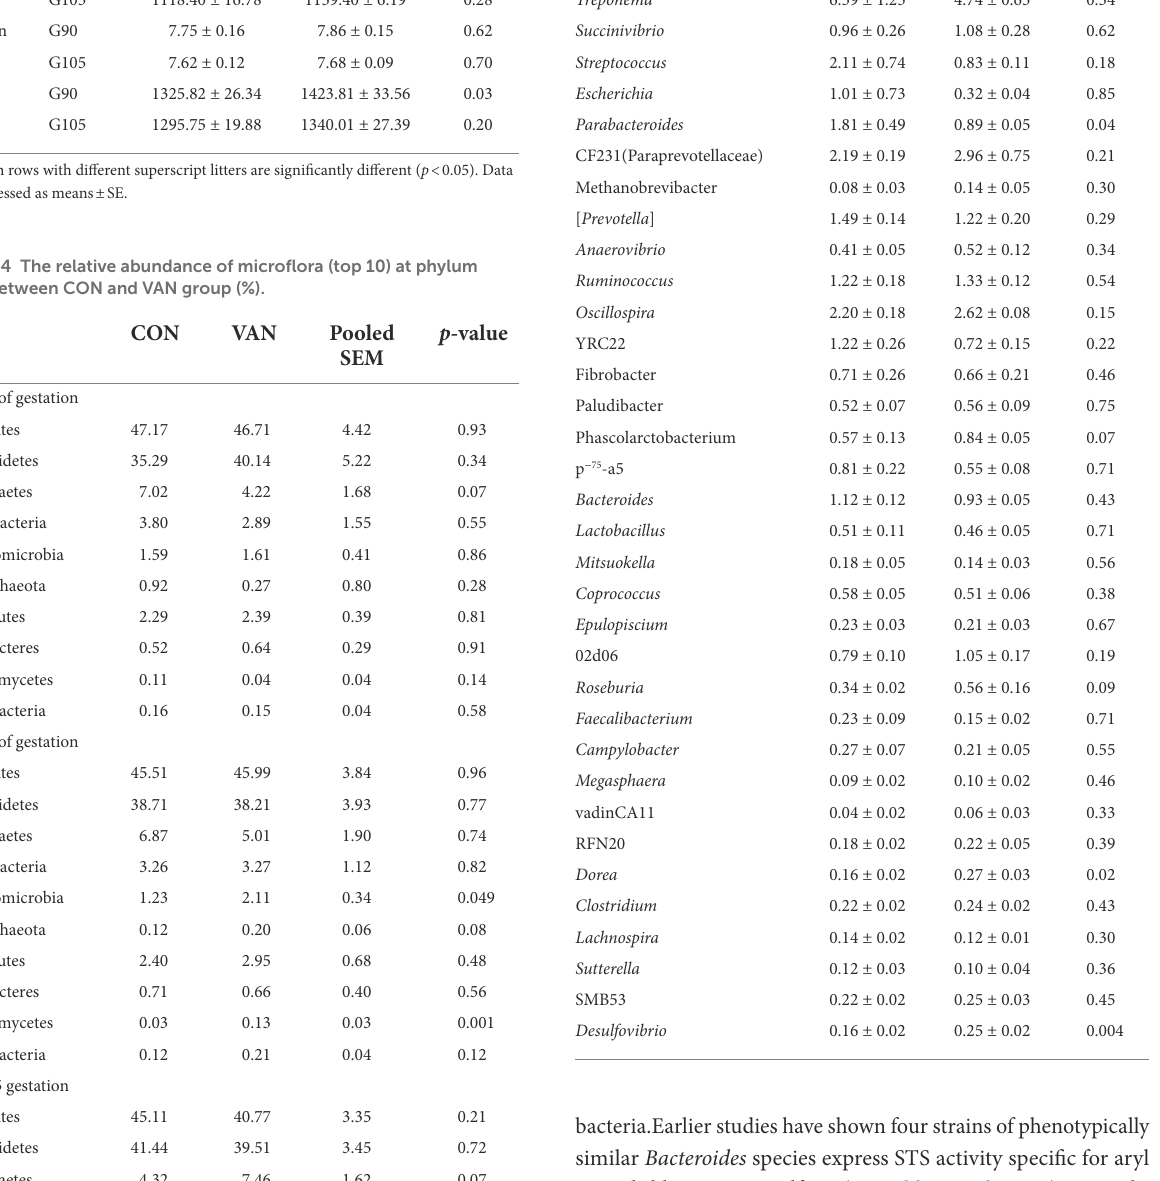
TABLE 5 The relative abundance of microflora (top 35) at genera level between CON and VAN group at day 90 of gestation (%). CON VAN p